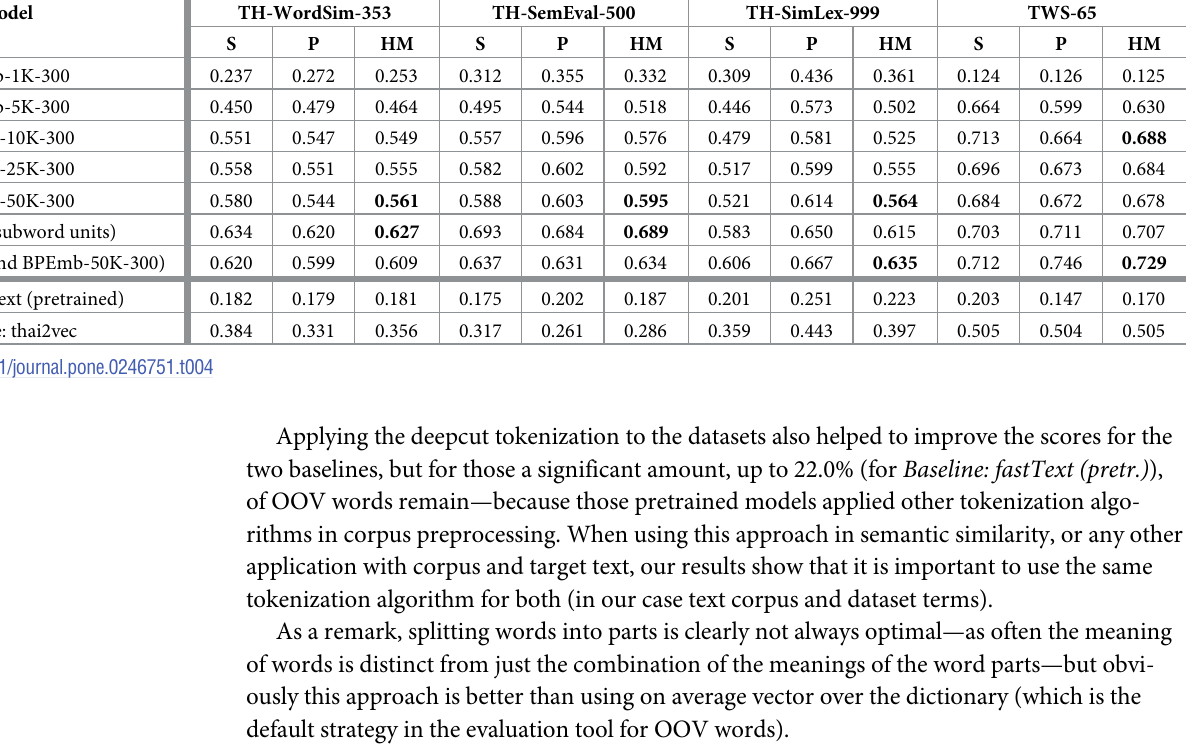
Table 4. Overview of results for BPEmb (various settings), fastText embeddings, and stacked embeddings; with comparison to the baselines. Model